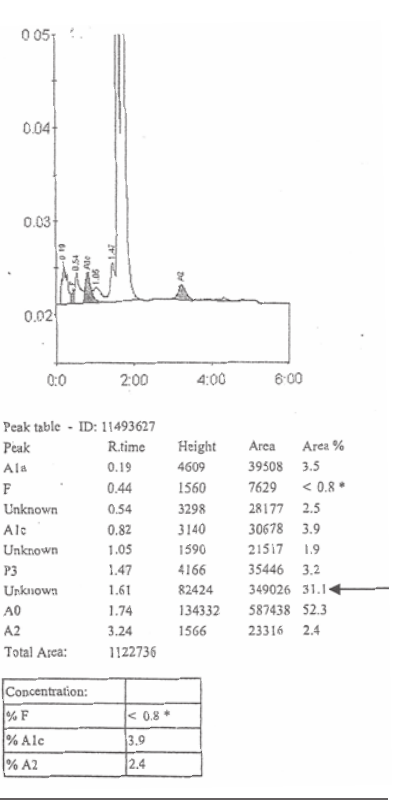
Figure 1. High-performance liquid chro- matography using Bio-Rad D10 showing the hemoglobin variant peak of 31.1% running between the P3 and A0 peaks with a retention time of 1.61 (arrow).